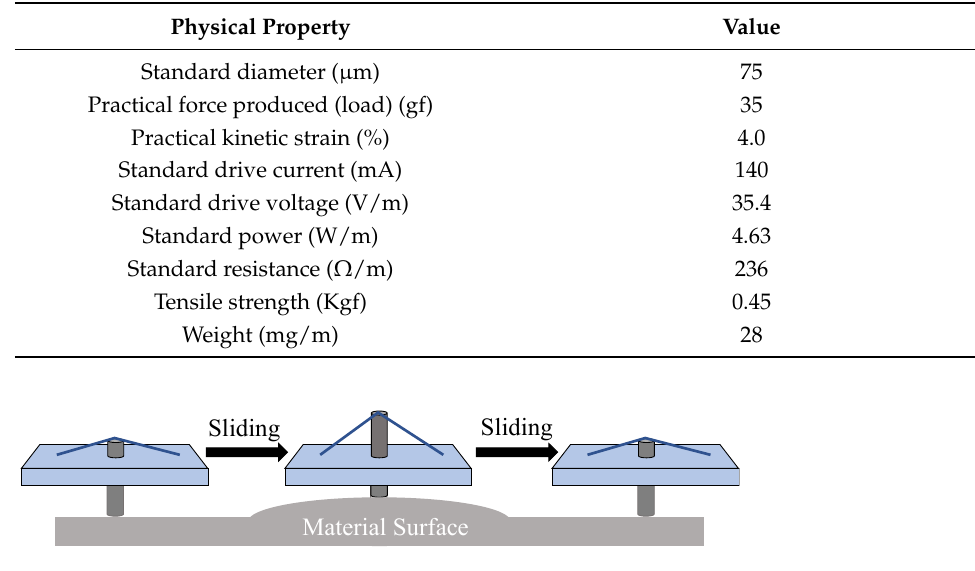
Figure 5. Sliding the SMA sensor on material surface.